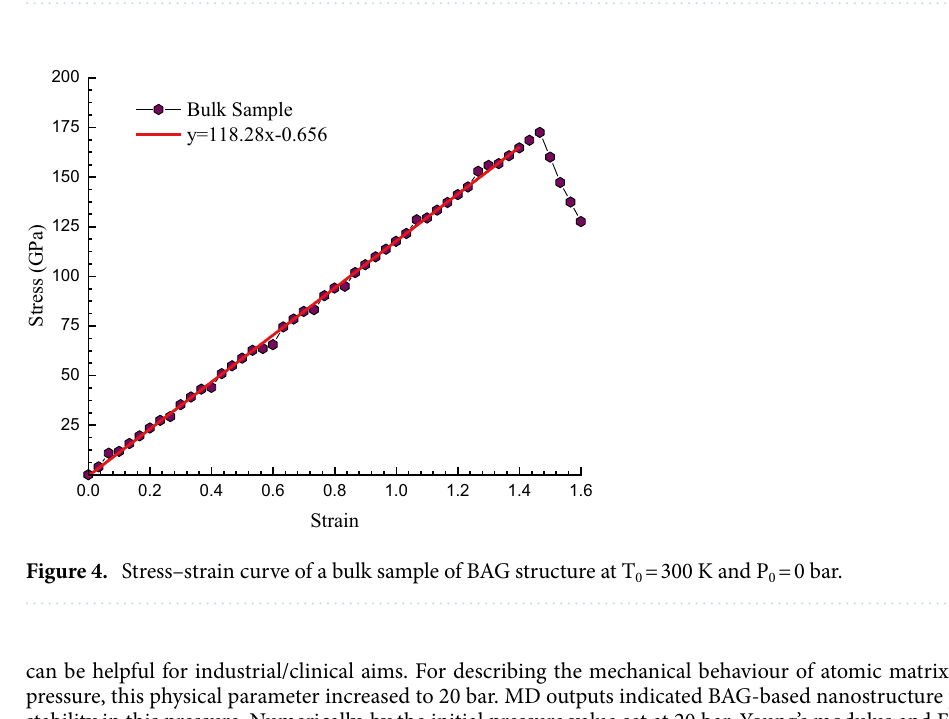
Figure 3. Density of BAG-based nanostructure change in MD simulation time at T 0 = 300 K and P 0 = 0 bar.